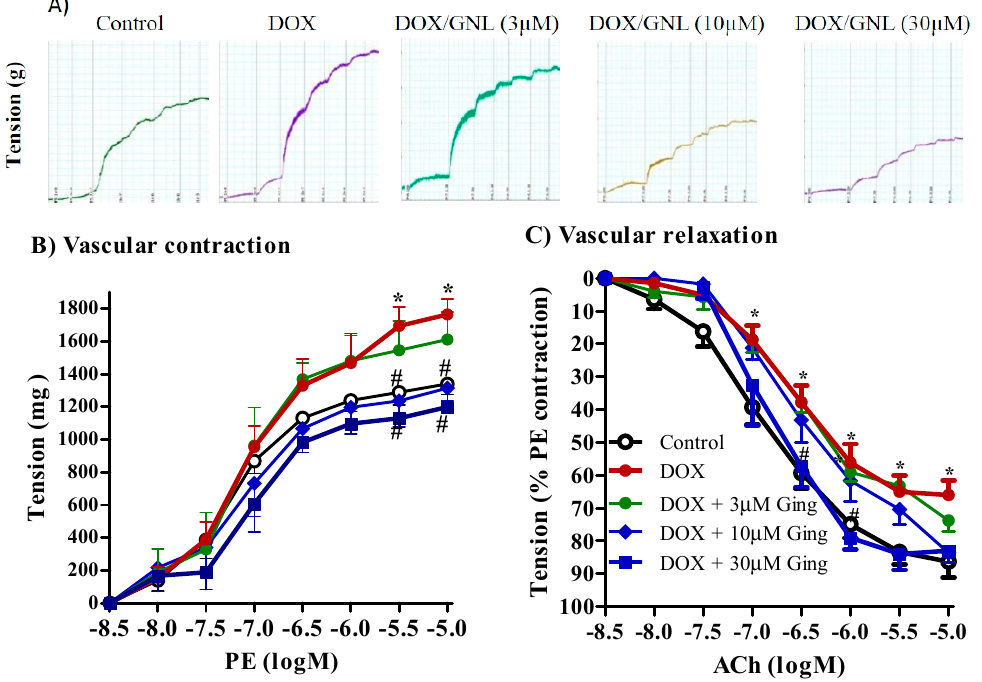
Figure 7. Effect of in vitro incubation with 6-gingerol (3, 10 and 30 µM) on doxorubicin (DOX, 10 µM)-induced exaggerated vasoconstriction to phenylephrine (PE), ( A , B ) and impaired vasodilation to acetylcholine (ACh) ( C ). A Data is presented as mean ± SD; n = 6–8. *: significantly different from control group; #: significantly different from DOX treated group.